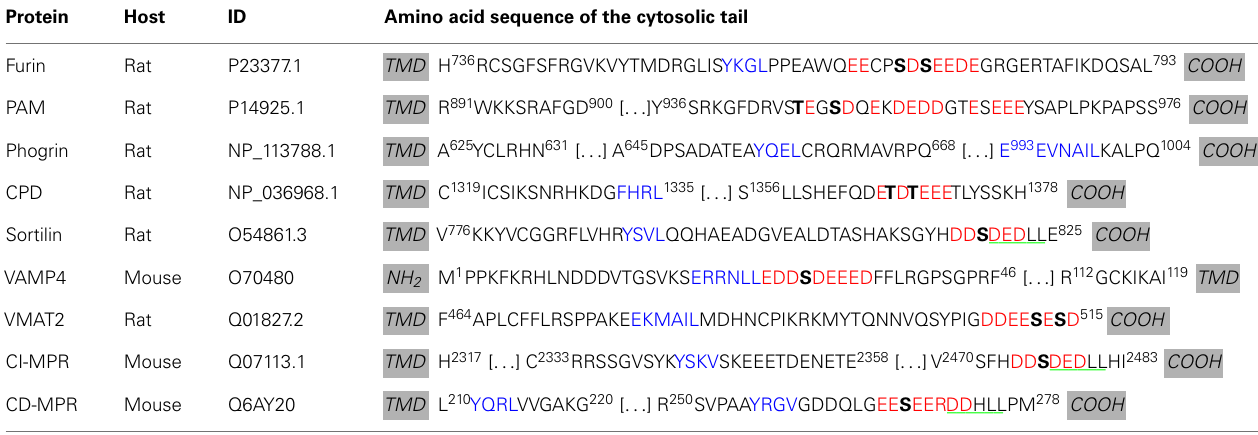
Protein, host, and ID are shown. Acidic clusters are in red. CKII sites are in bold. AP-1 and AP-1-like sites are in blue and GGA sites are underlined in green.TMD, transmembrane domain; COOH, C-terminus of the protein; NH 2 , N-terminus of the protein.The gray shade and italic font was to help the reader distinguish COOH orTMD or NH 2 from the amino acid